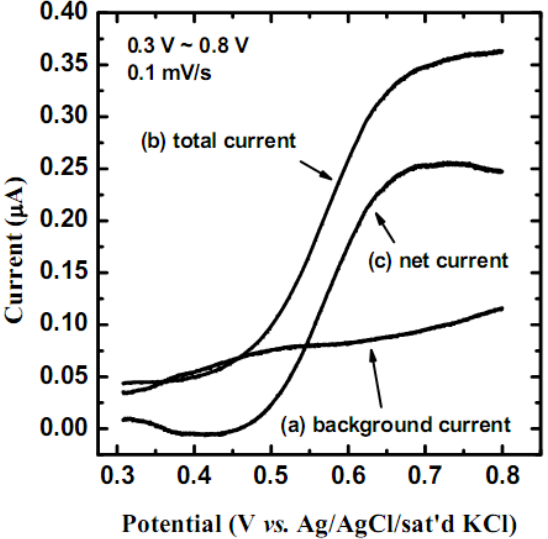
Figure 6. The LSV of electrode C scanned from 0.30 to 0.80 V ( vs . Ag/AgCl/sat’d KCl) in background electrolyte (a) and 8 mM cholesterol solution (b), at a scan rate of 0.1